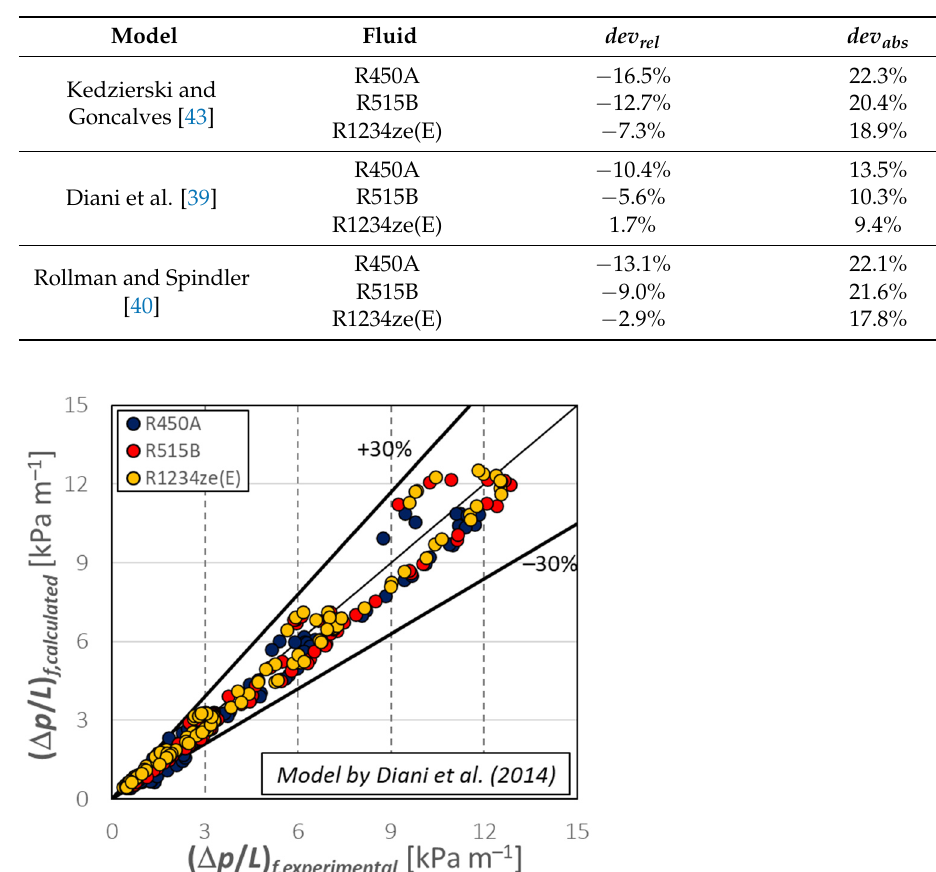
Table 5. Accuracy of implemented correlations for pressure gradient.